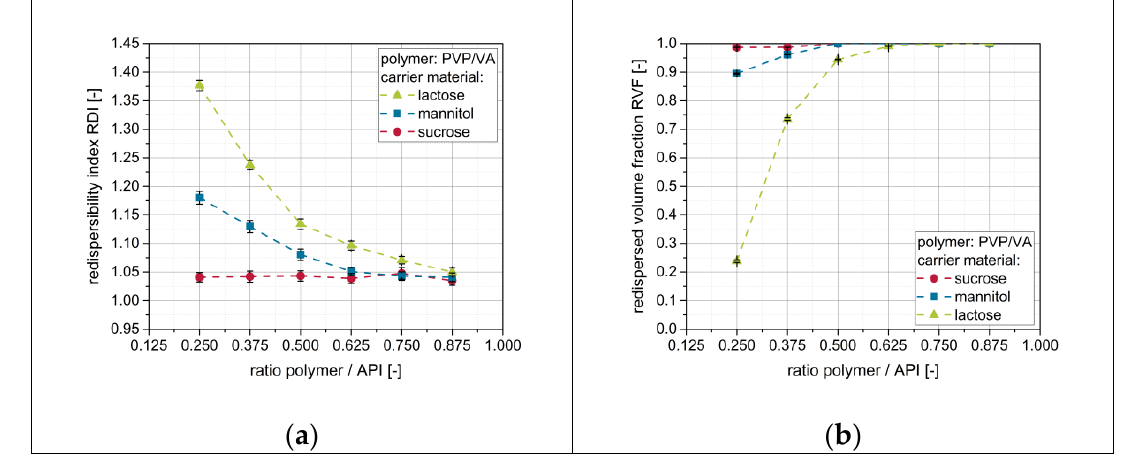
Figure 7. Effect of additional polymer (PVP/VA) in the granulation fluid on the redispersibility of Figure 7. E ff ect of additional polymer (PVP / VA) in the granulation fluid on the redispersibility of granules produced with different carrier materials (lactose, mannitol, sucrose). Measurement of granules produced with di ff erent carrier materials (lactose, mannitol, sucrose). Measurement of redispersed suspensions was carried out by means of ( a ) DLS and ( b ) LD. redispersed suspensions was carried out by means of ( a ) DLS and ( b )